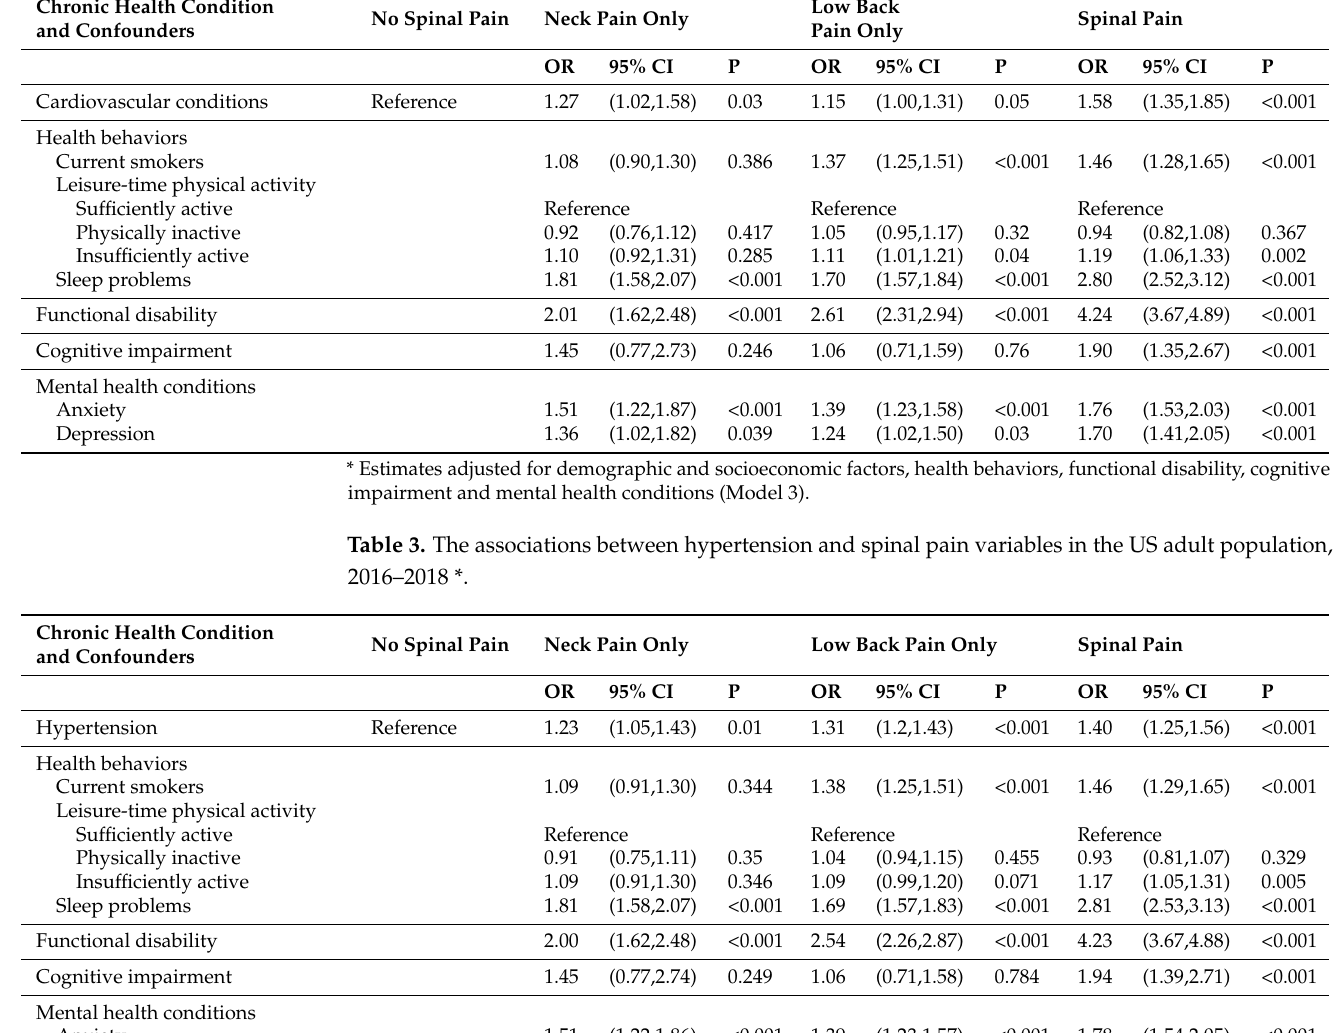
Table 4 shows Model 3 for the associations between diabetes and spinal pain